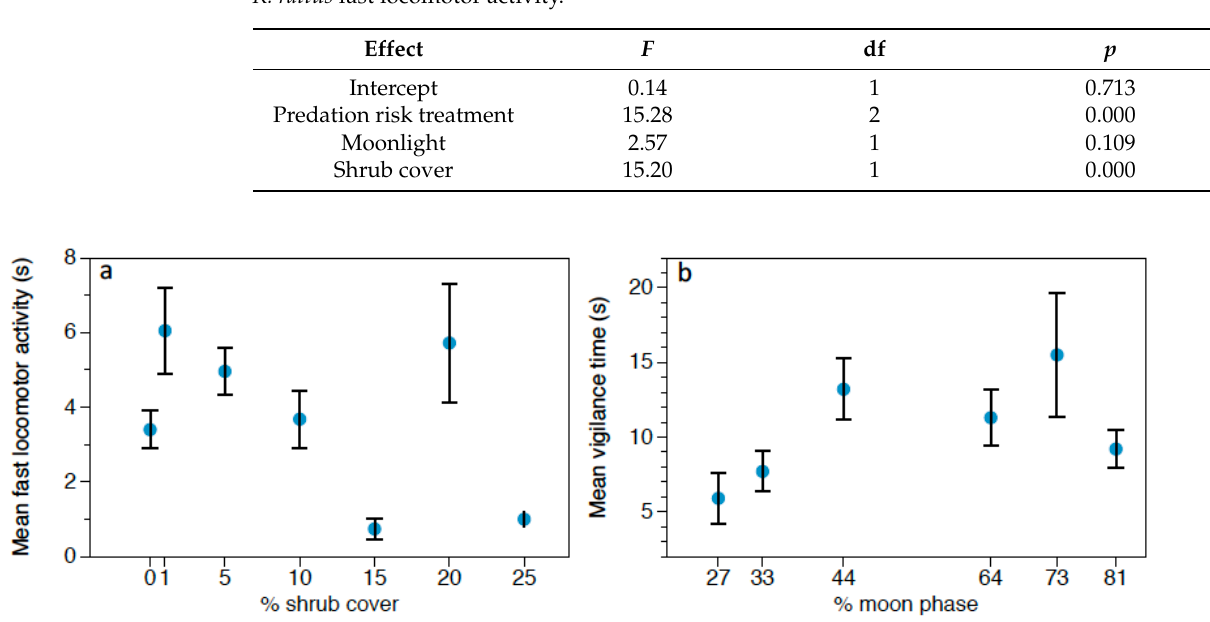
Figure 6. ( a ) Mean fast locomotor activity time (s) ± SE displayed by R. rattus depending on the shrub cover thickness. ( b ) Mean vigilance time (s) ± SE of R. rattus depending on moonlight. Table 11. Results of the GLM analyzing the effect of experimental and environmental factors on R. rattus slow locomotor activity.